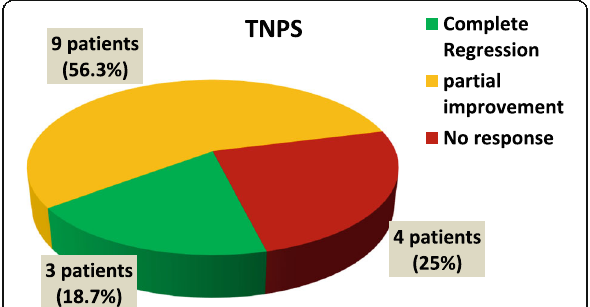
Fig. 2 Pie chart showing the effect of oral steroids on total nasal polyps score TNPS